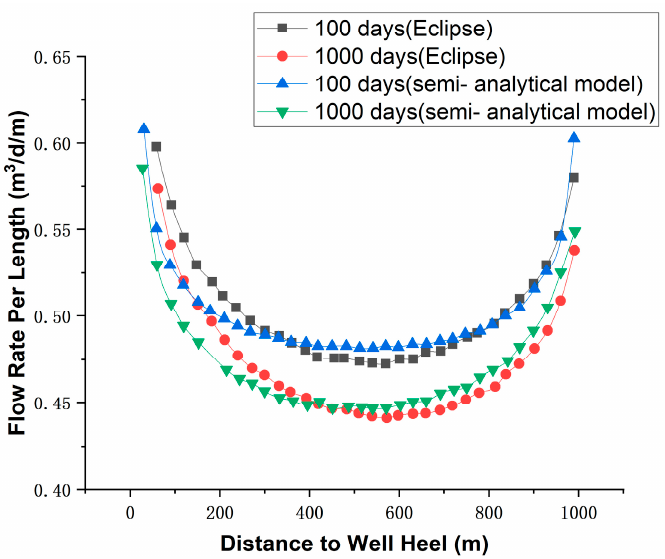
Figure 8. Inflow profile of wellbore. Figure 8. In fl ow pro fi le of wellbore.